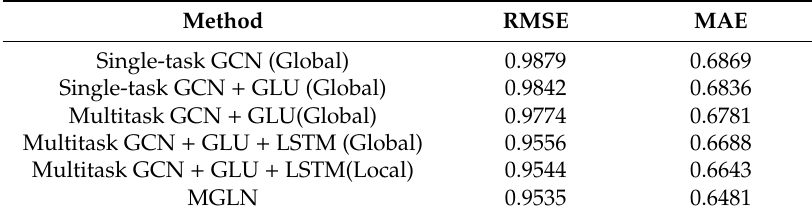
Table 3. Results of ablation